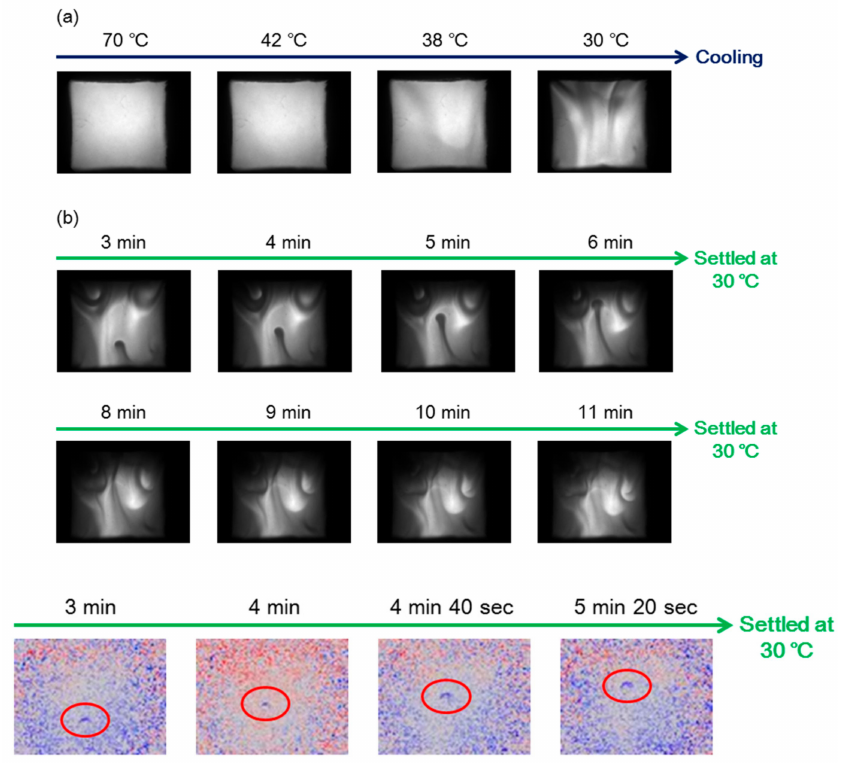
Figure 39. UV-vis images (320 nm) ( a ) and CD images (320 nm) ( b ) of 1:1 mixture of aminomethylenehelicene ( P )-tetramer and ( M )-pentamer in fluorobenzene during cooling from 70 to 30 ◦ C. Reproduced from reference 115 by permission from John Wiley &